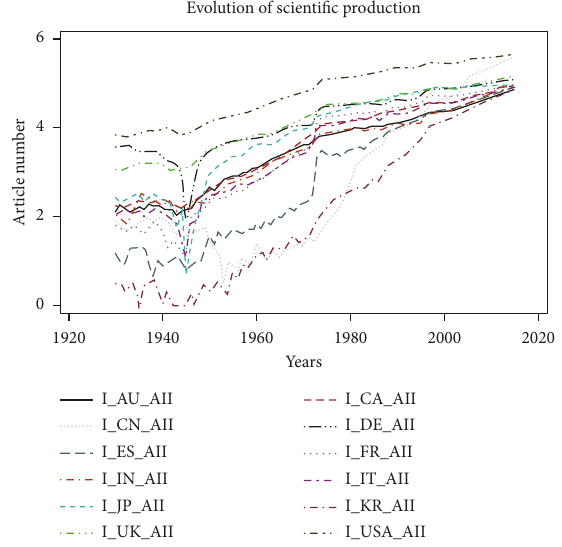
Figure 1: Evolution of scientific production worldwide. Source: